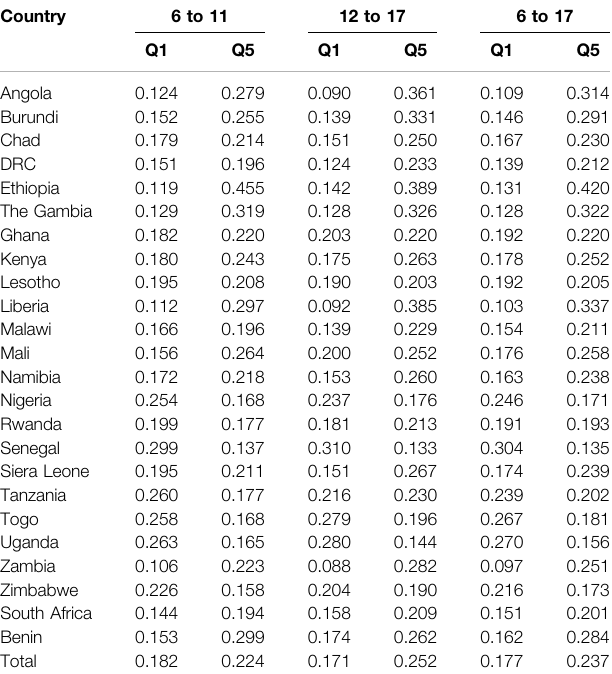
areas by wealth and age group. Country 6 to